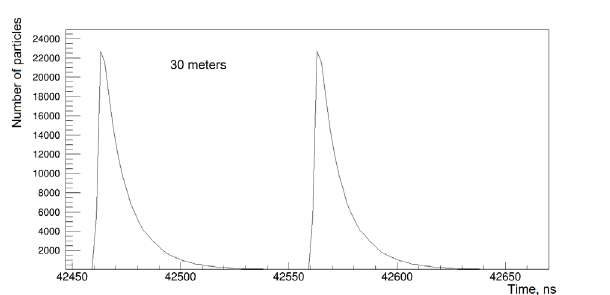
Figure 10. Two EAS disks with 100ns delay, detector is 30 m from axis.